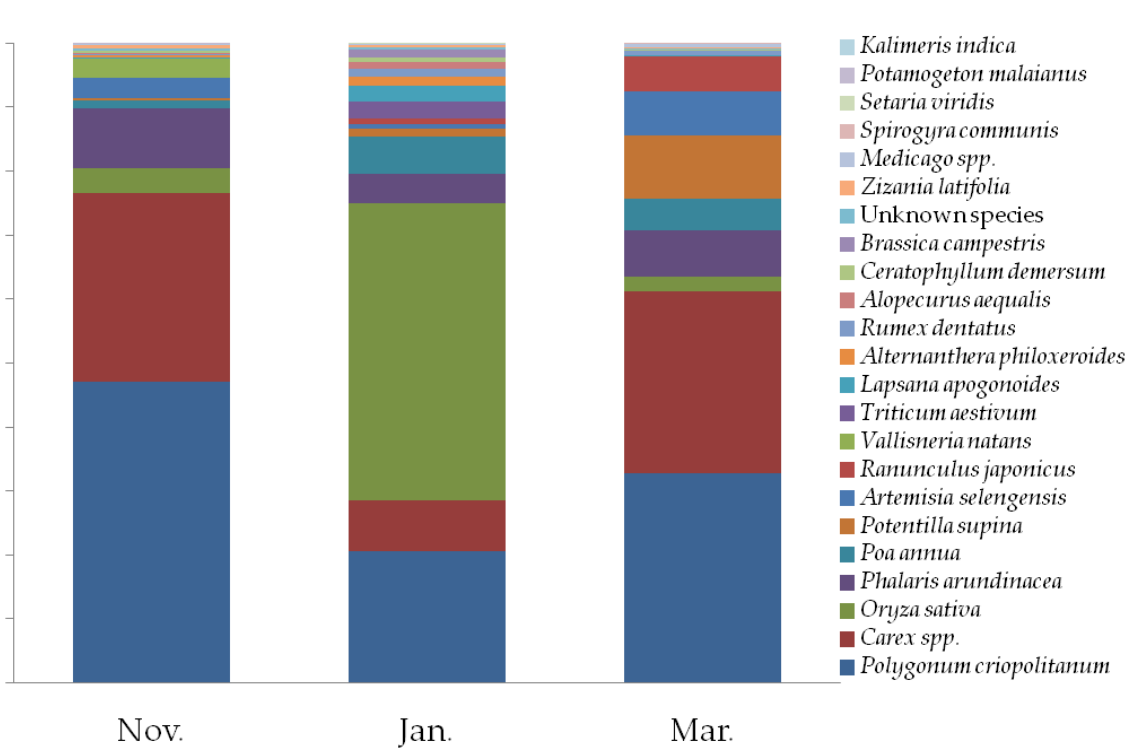
Figure 1. Relative density of foods of hooded cranes in the 3